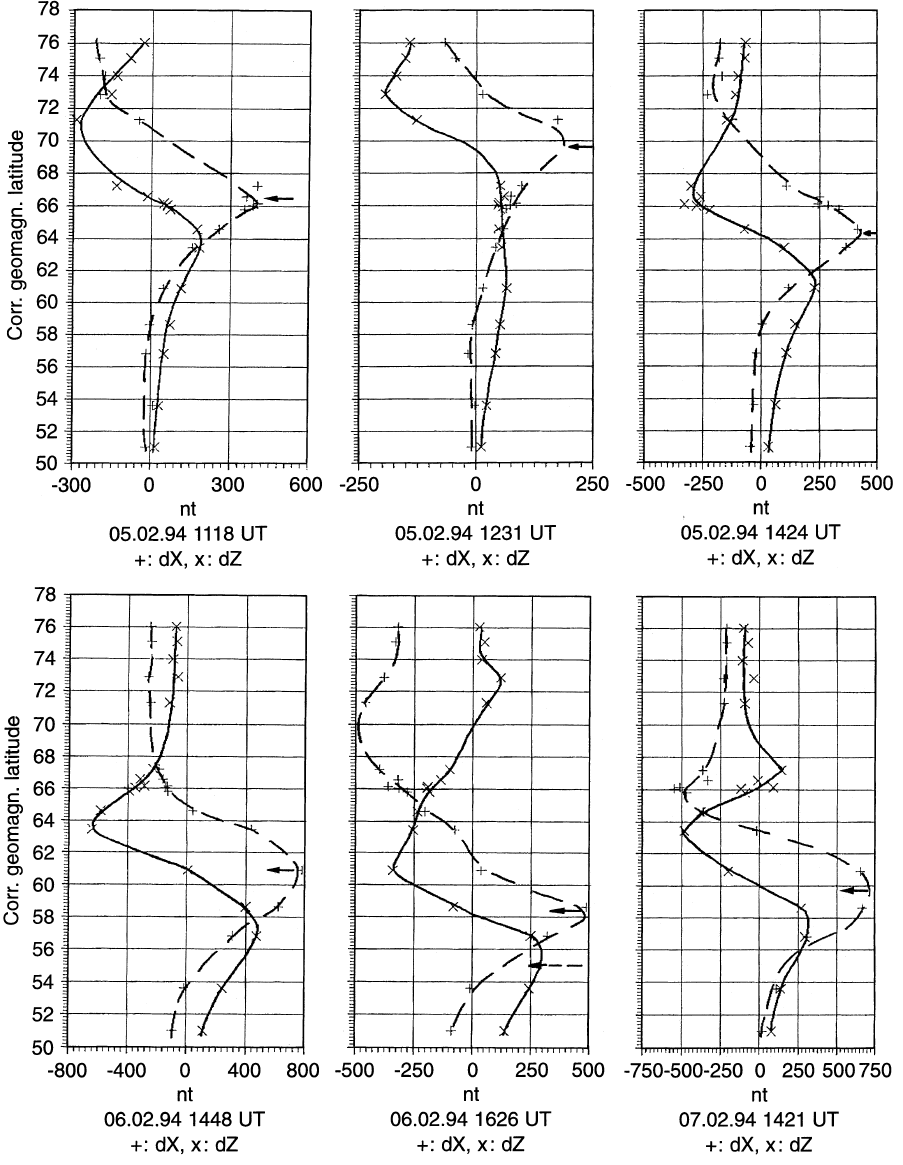
Fig. 2a–f. The latitudinal cross sections D X ( dashed line ) and D Z ( solid line ) through the eastward electrojet on February 05, 1994 at 1118 UT, 1231 UT and 1424 UT, February 06 at 1448 UT and 1628 UT, February 07 at 1421 UT. Arrows mark the latitudes of the eastward electrojet center. The dashed arrow on February 06 at 1626 UT marks the position of the east- ward electrojet on May 10, 1992 at 1514 UT, when Dst (cid:136)